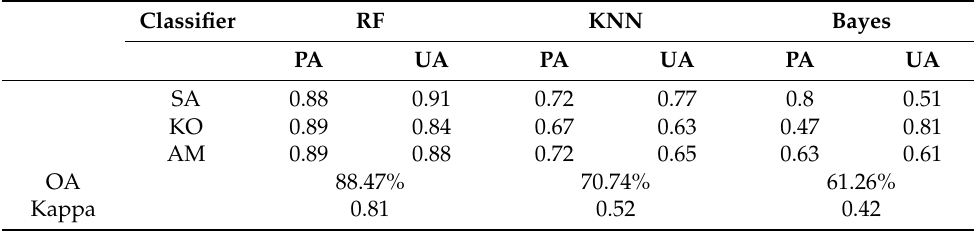
Table 6. Classification accuracy table of three comparison methods based on preferred features (classification accuracy includes overall accuracy, Kappa, PA, and UA).